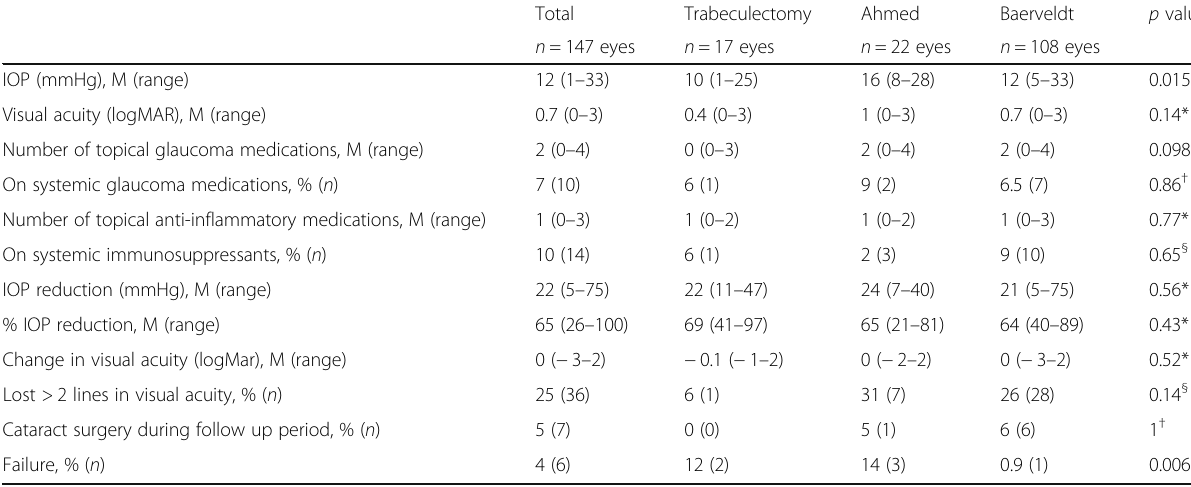
Table 2 Six-month postoperative outcome